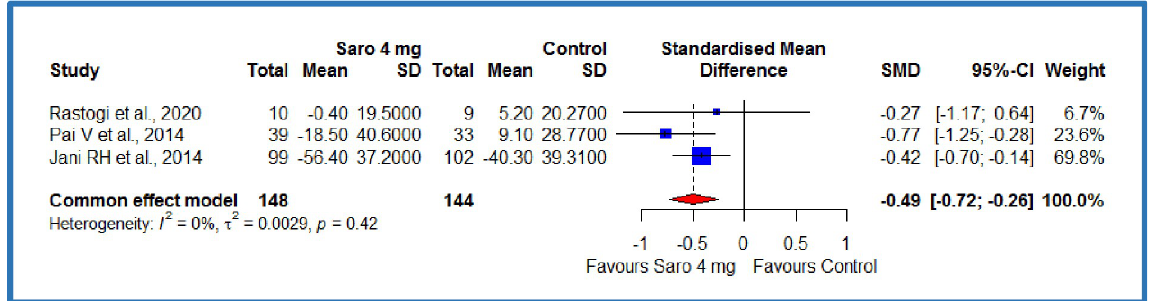
Fig 5. Forest plot of comparison of saroglitazar 4mg versus control on total cholesterol (mg/dL).